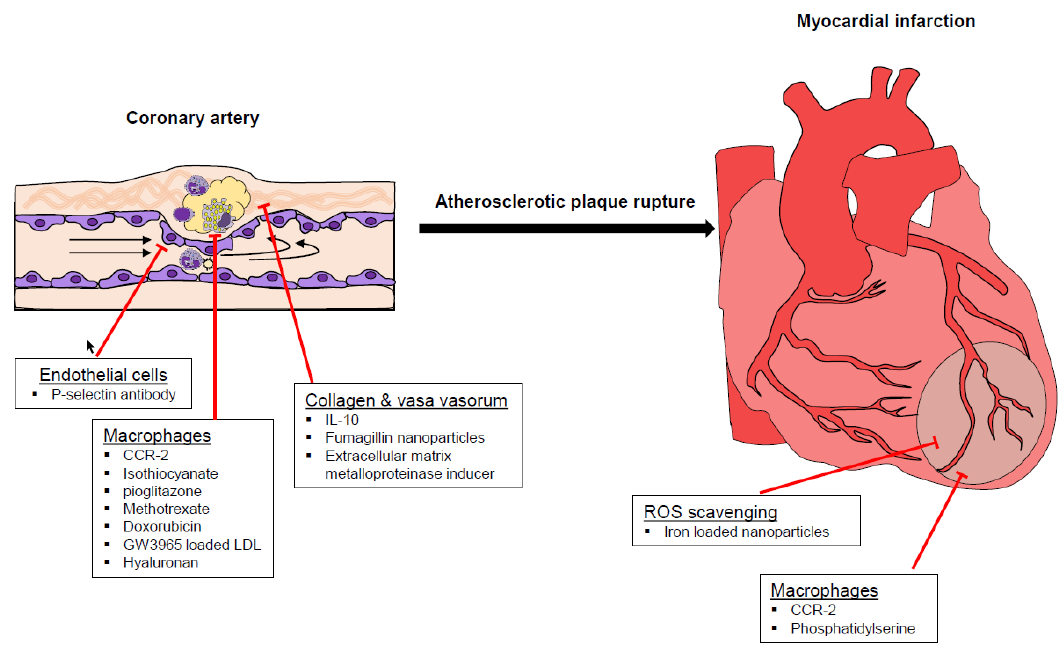
Figure 1. Studies on nanoparticles in atherosclerosis cover different steps of atherosclerotic disease from the early development of fatty streaks to the athero-thrombotic consequences. Current approaches mainly involve endothelial cells, extracellular matrix and especially macrophage recruitment and function. CCR: C-C chemokine receptor; IL-interleukin; ROS: Reactive oxygen species.